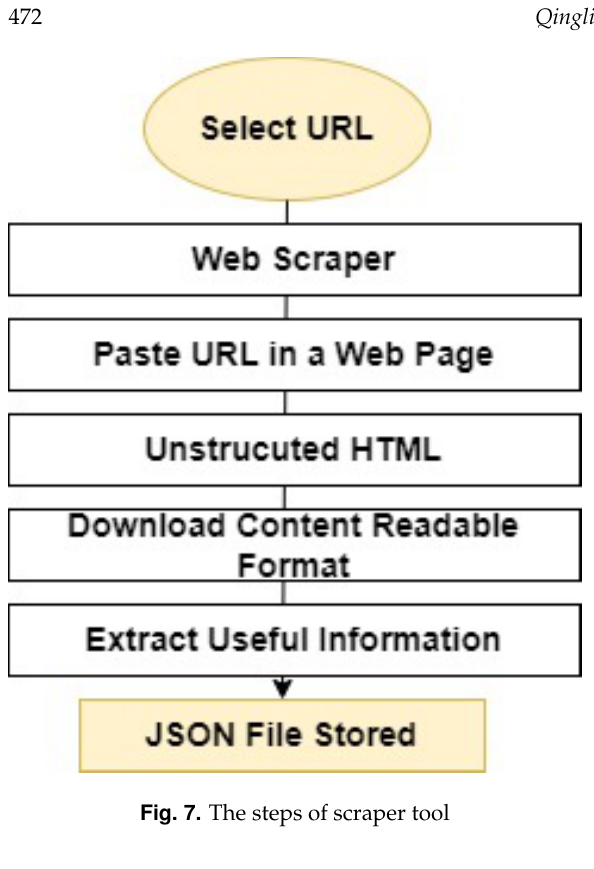
Fig. 7. The steps of scraper tool